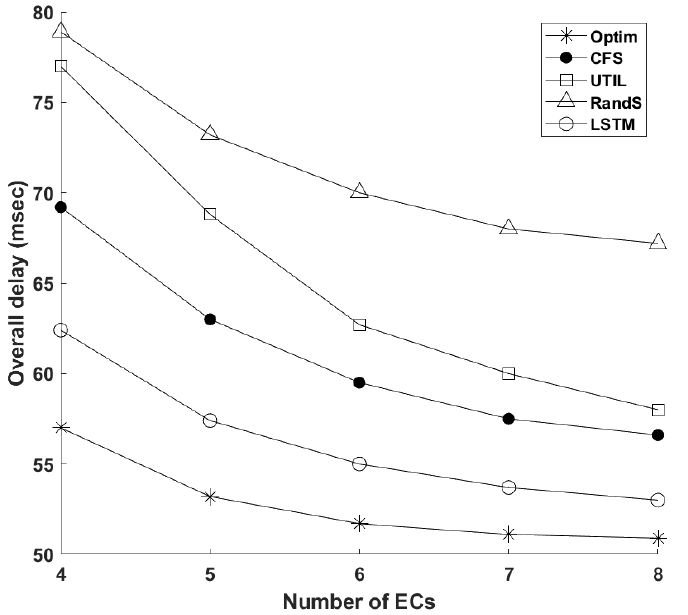
Figure 9. Service Delay with Different Number of ECs (30 Requests, µ = 0.5, EC Capacity is 14 and Total Moving Probability is 1). CFS [34]; UTIL